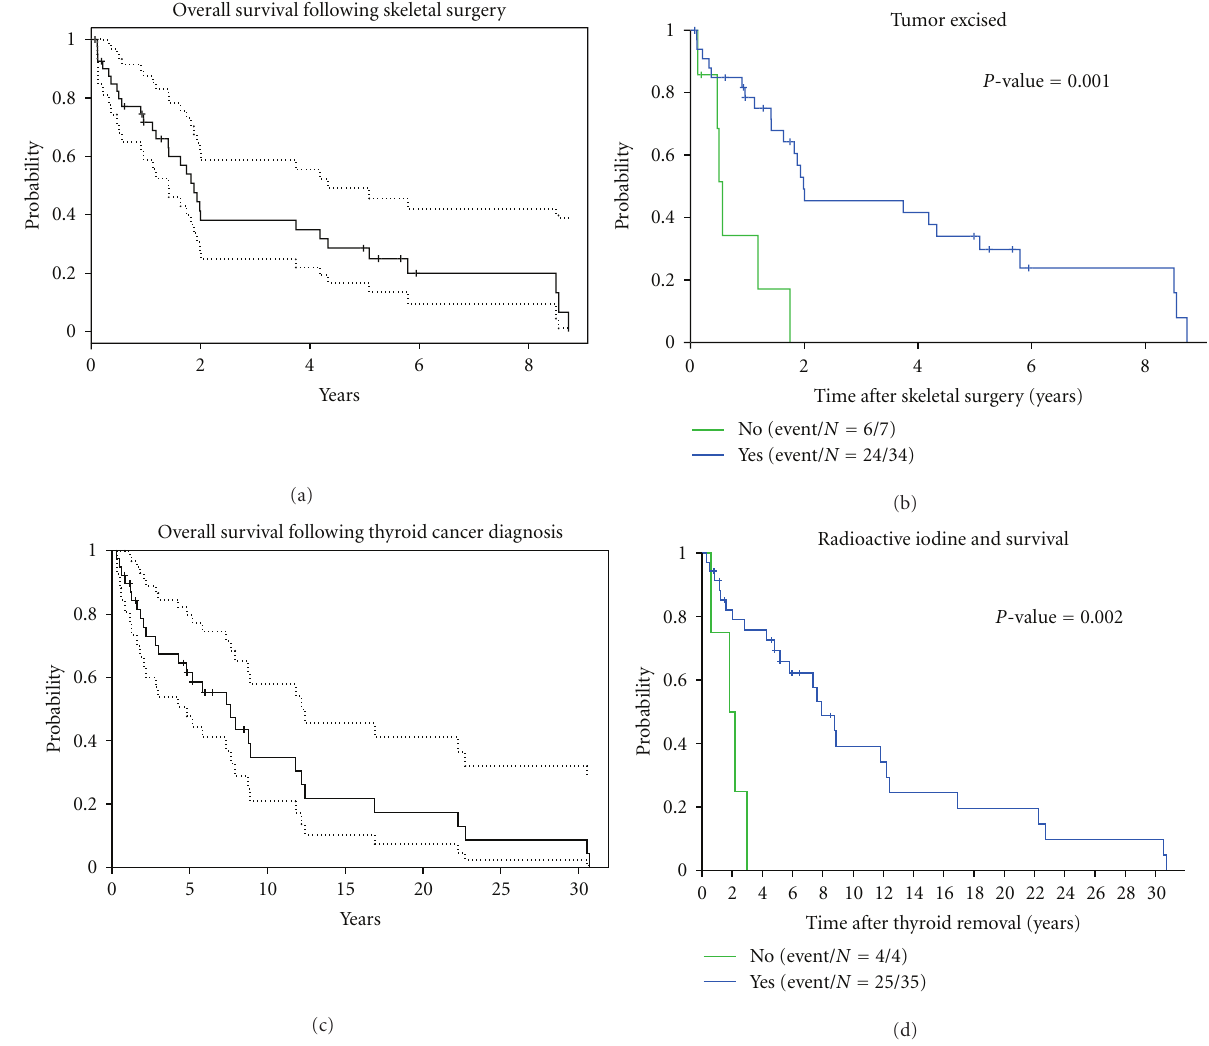
Figure 2: Kaplan-Meier analysis of patient survival. (a) Following surgery for osseous metastases patient survival was 72% at 1 year (95% CI 59–87%), 29% at 5 years (95% CI 17–49%), and 20% at 8 years (95% CI 10–42%). (b) There was better survival for patients when the metastastic osseous tumor was excised versus not excised. The median survival time for patients with tumor excision was 2 years (95% CI 1.4–5 years), compared with 0.6 years (95% CI 0.1–1.8 years) for patients without tumor excision ( P = 0 . 001). No patient without tumor excision survived beyond 1.8 years. (c) Following thyroidectomy at initial diagnosis of thyroid carcinoma patient survival was 62% at 5 years (95% CI 48–80%), 35% at 10 years (95% CI 21–58%), 17% at 20 years (95% CI 7–41%), and 9% at 30 years (95% CI 2–32%). (d) After thyroid removal, patients who received radioactive iodine treatment had better survival than those who did not ( P = 0 .